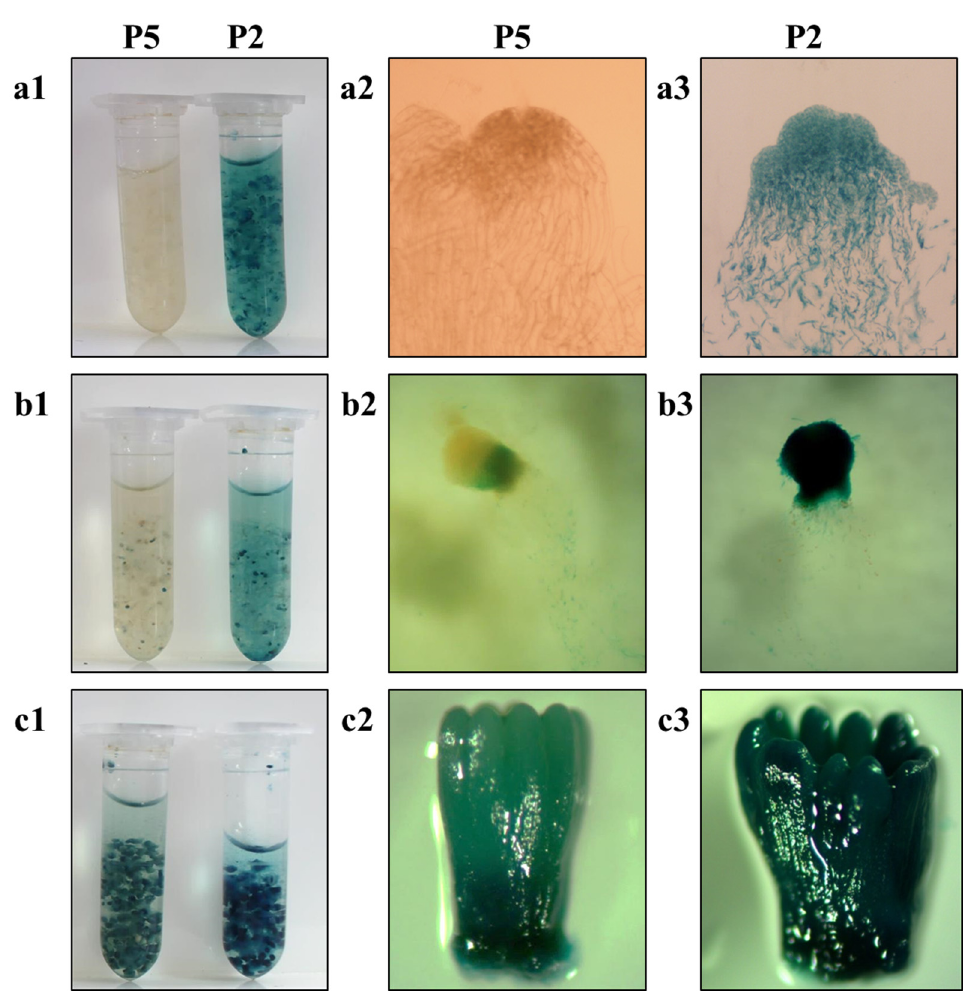
Figure 5. Histochemical detection of the GUS staining in somatic embryos at different developmental stages from transgenic cell lines P2 and P5. ( a ) Embryogenic tissues, ( b ) early embryos cultured for 15 days, ( c ) mature somatic embryos cultured for 42 days on differentiation medium supplemented with abscisic acid. ( a1 , b1 , c1 ) Panoramic images of GUS staining of the above three tissues of P2 and P5, ( a2 , b2 , c2 ) microscopic images of GUS staining of the above three tissues of P5, ( a3 , b3 , c3 ) microscopic images of GUS staining of the above three tissues of P2.